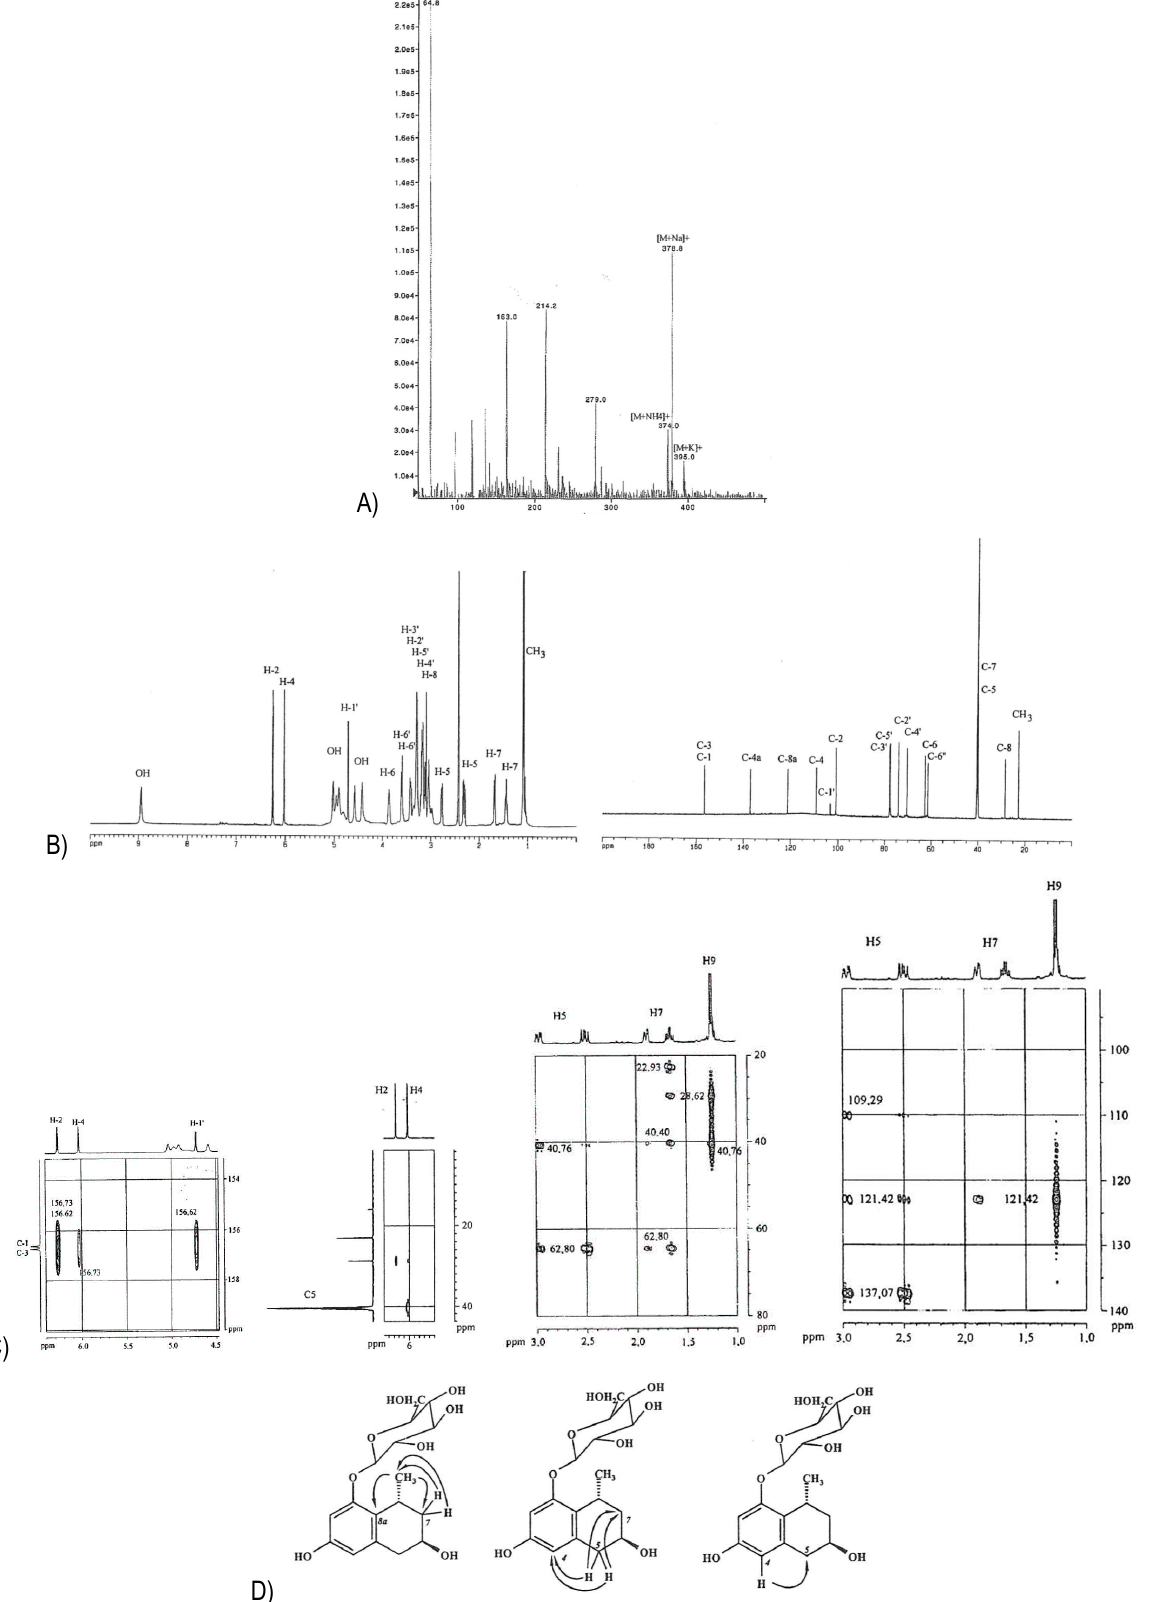
Figure 7. ( A ) ESI-MS of 9 ; ( B ) 1 H- (left) and 13 C-NMR spectra (right) of 9 ; ( C ) excerpts from its HMBC spectrum; ( D ) couplings in 9 as presented in the HMBC spectrum.